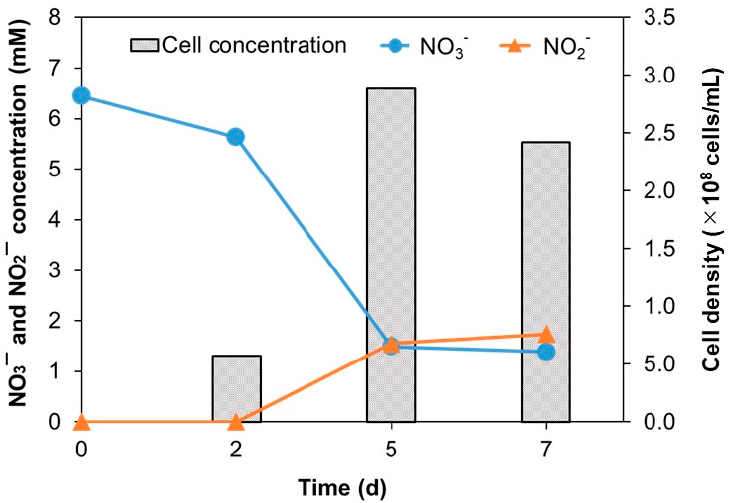
supplemented with Figure 3. Changes in the NO 3- and NO 2- concentrations and NIT-T3 cell densities in the culture sup- plemented with nitrate.